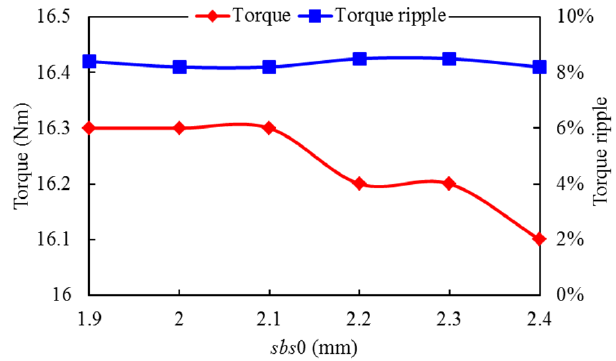
Figure 9. Variations of torque and torque ripple with sbs0 . Energies 2022 , 15 , x FOR PEER REVIEW 11 of 24